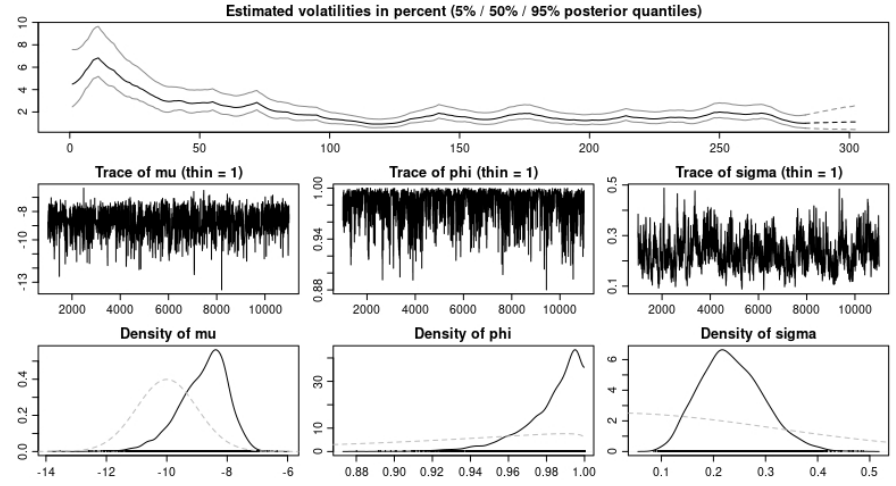
Figure 3. Graph showing estimated volatility for the Russell.